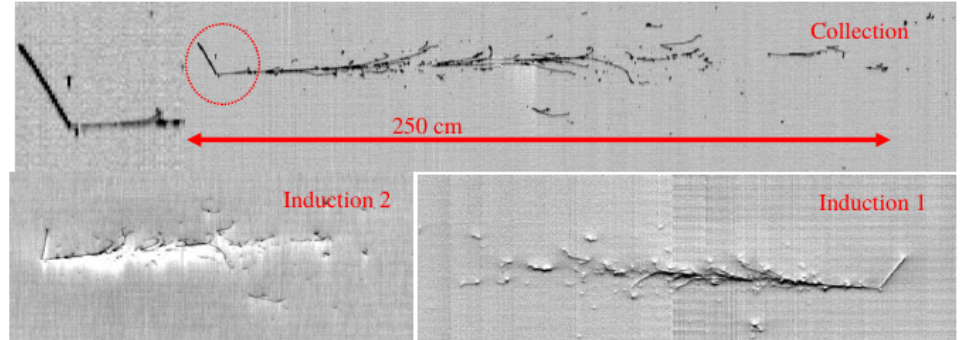
Figure 9. Example of a quasi elastic, downward-going atmospheric charged-current electron neutrino found in the scanned sample. A clear e.m. shower of 2 GeV is observed, while a 115 MeV kinetic energy proton emerges from the main interaction vertex as a single, highly ionizing track.